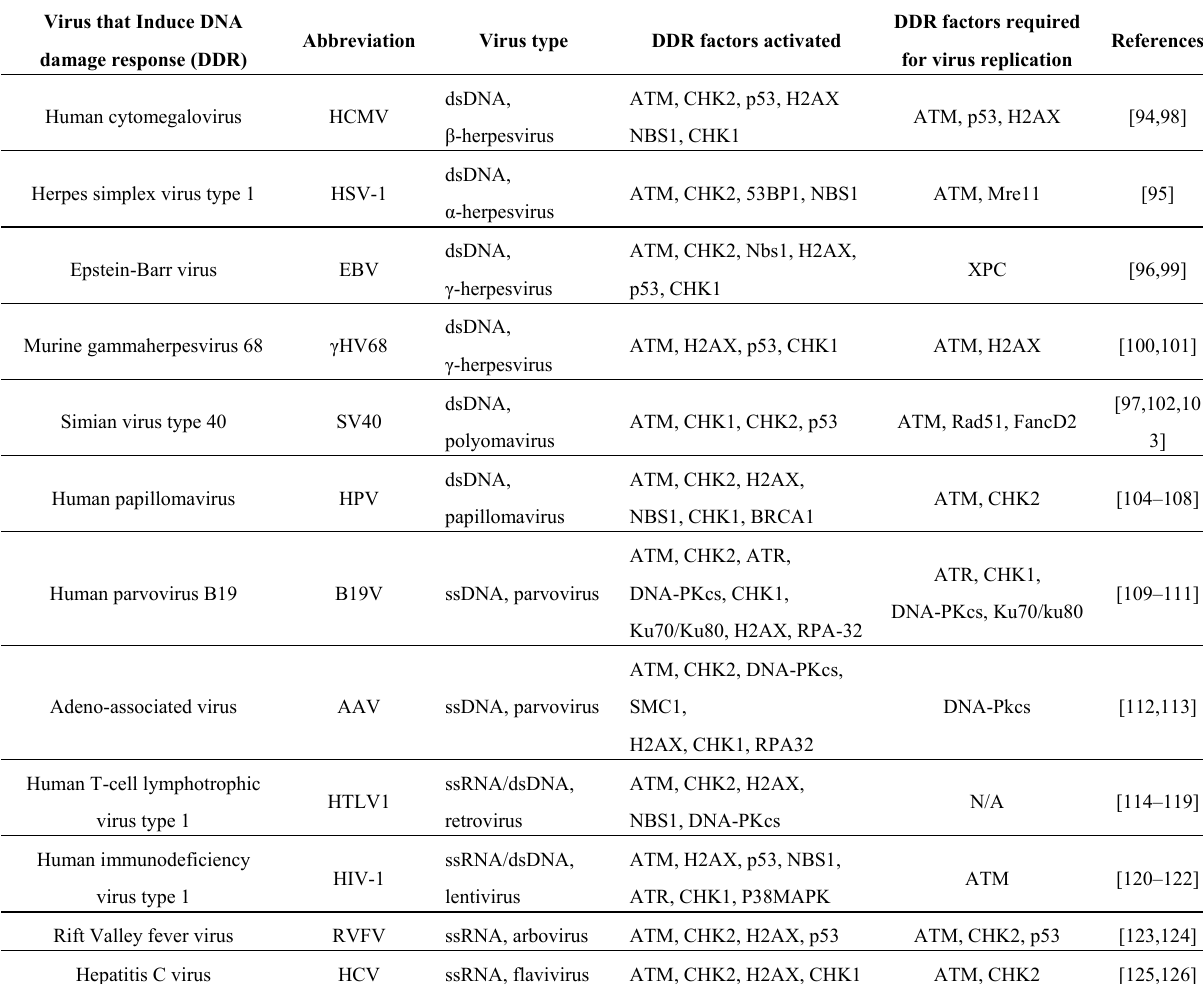
Table 1. A list of viruses that both induce and require host DNA damage responses (DDR) for productive